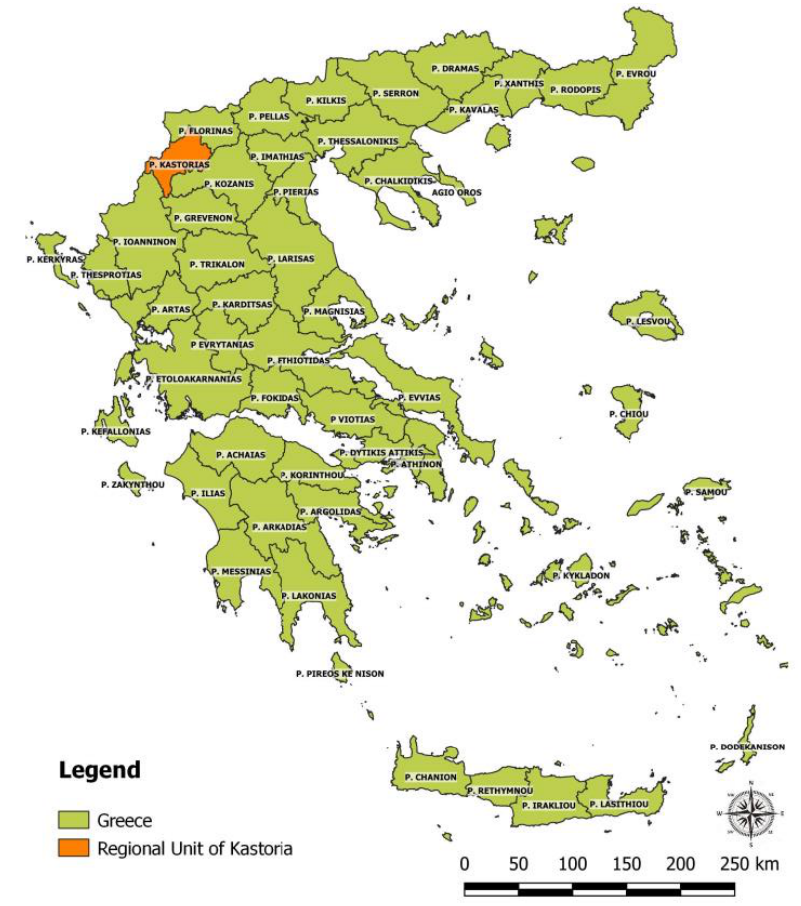
Figure 1. Study Area of PGI beans products.